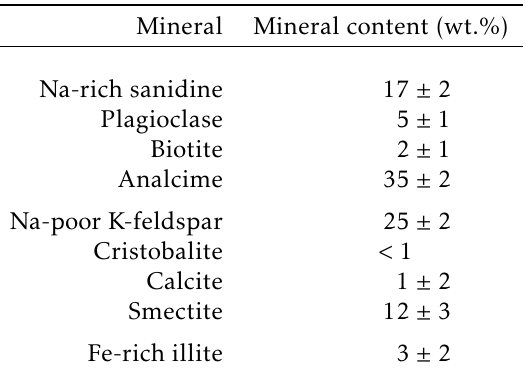
Table 1 – Quantitative bulk mineralogical composition, determined using X-ray powder di ff raction (XRPD), for the “as collected” (i.e. material that has undergone no heating or deformation) Mt. Epomeo Green Tu ff (MEGT) used in this study.